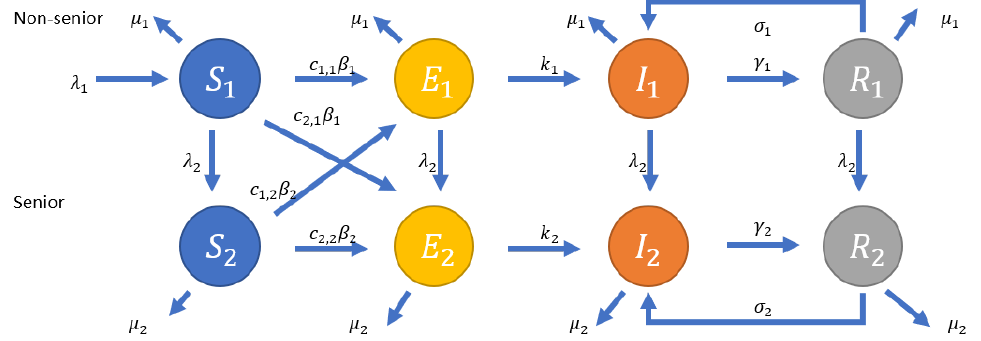
Figure 3. TB-transmission diagram for the 2-age group model (model (2) and